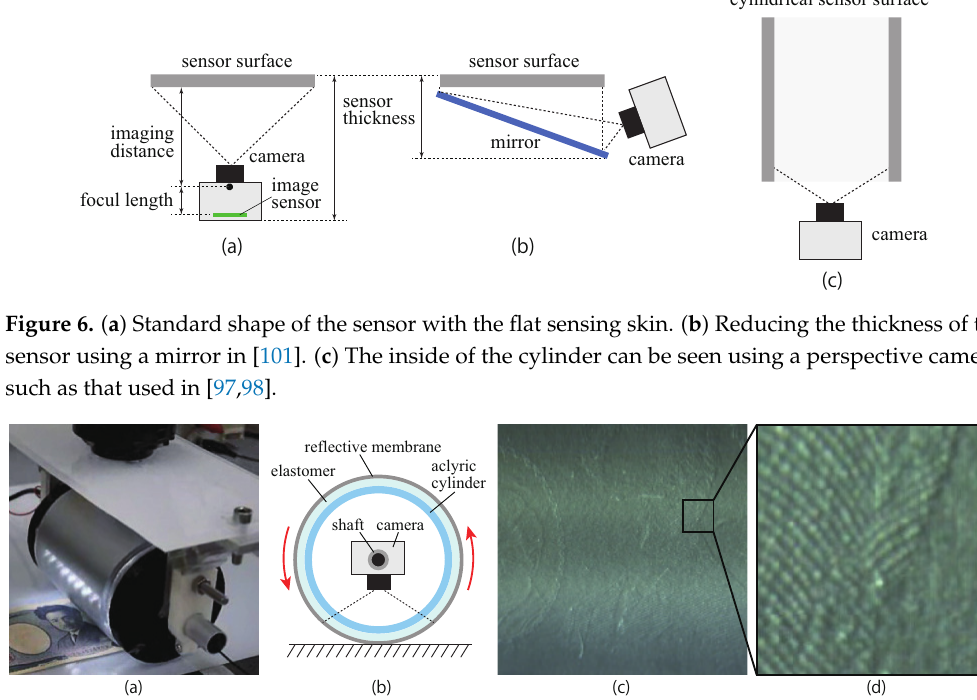
Figure 7. Rolling cylindrical tactile image sensor. ( a ) Picture of the sensor rolling on the surface of the object (a Japanese bill), ( b ) structure of the sensor, ( c ) output image obtained through a image mosicking, ( d ) enlarged output image. The video of the experiment is available: